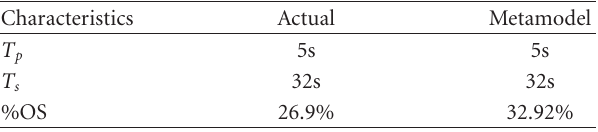
Table 6: System response characteristics for linear model.